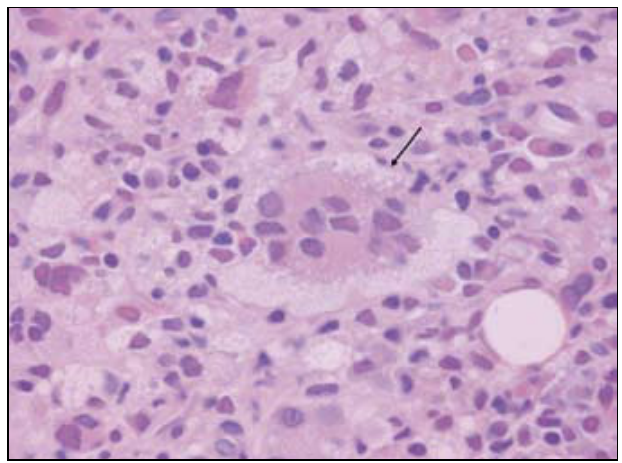
Fig. 3. Histological stain from the core